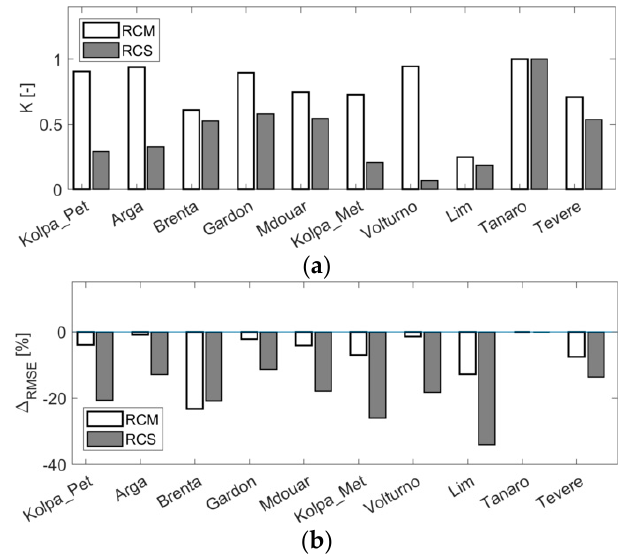
Figure 4. Values of the calibrated gain parameter K for P ERA and the P 3B42RT obtained during the calibration period ( a ) and % reduction in RMSE between observed and simulated stream flow during the calibration period ( b ). K close to zero indicates that more weight is assigned to P SM2RAIN-ASCAT dataset according to Equation